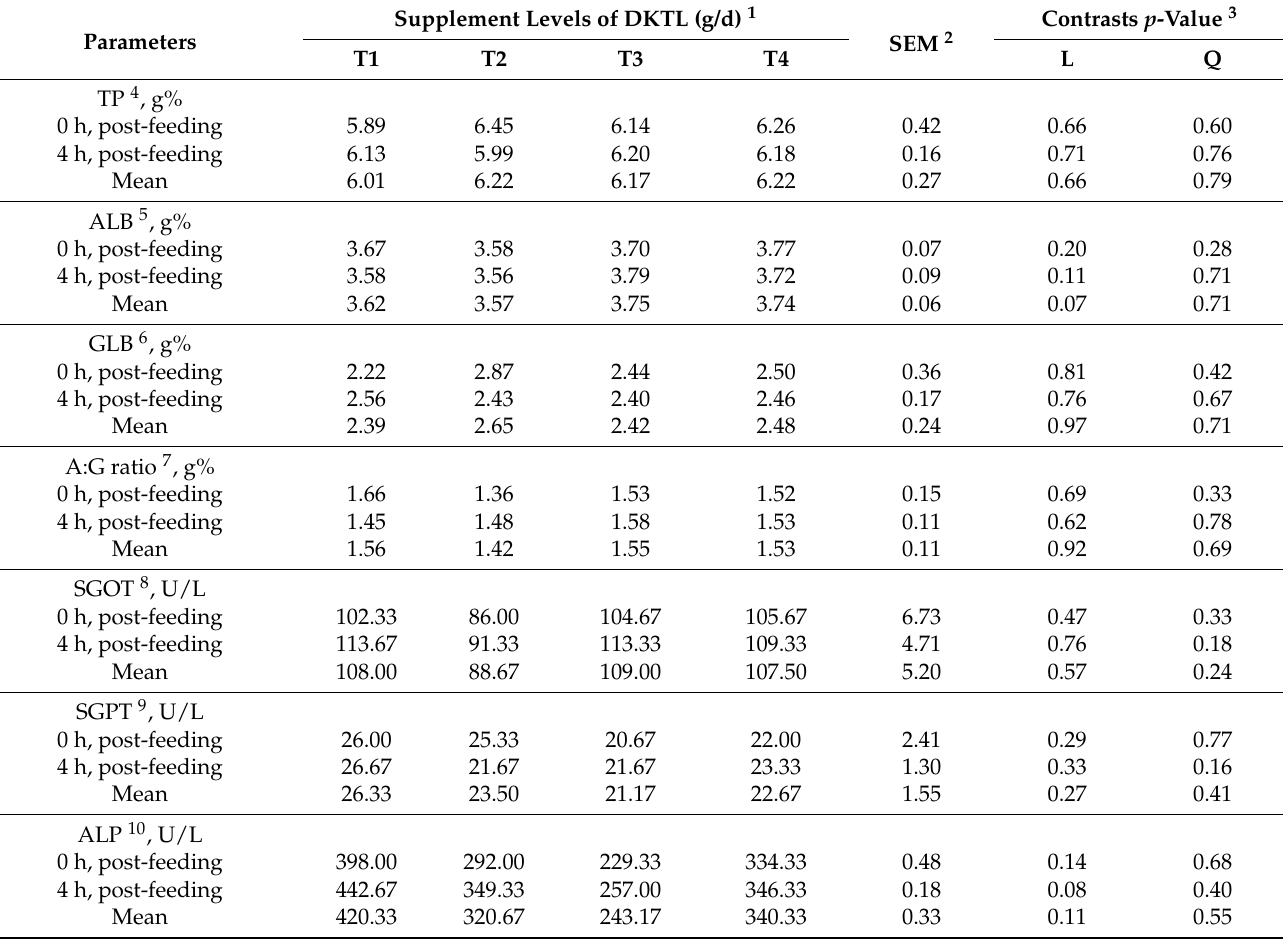
Table 8. Effects of Kratom leaves supplement on hematology parameters of fattening